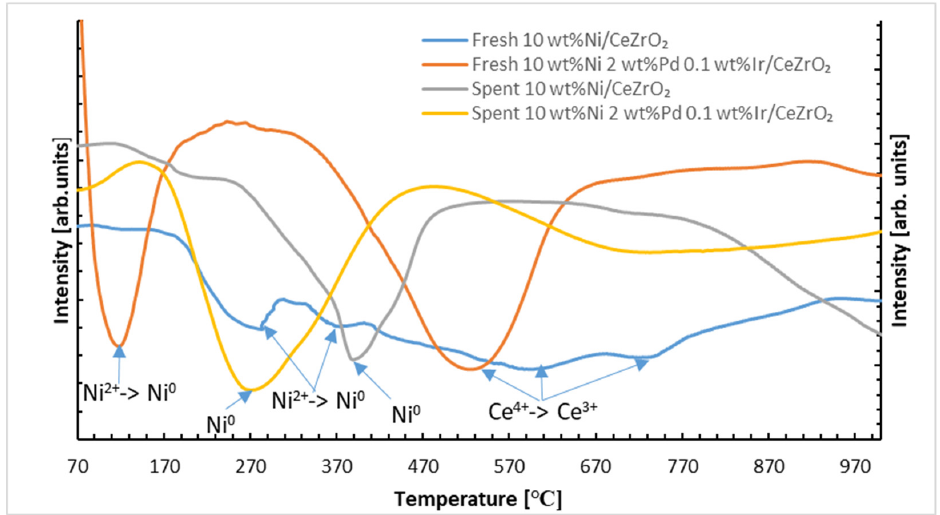
Figure 2. TPR-H 2 of fresh and spent 10 wt%Ni 2 wt%Pd 0.1 wt%Ir/CeZrO 2 and 10 wt%Ni/CeZrO 2